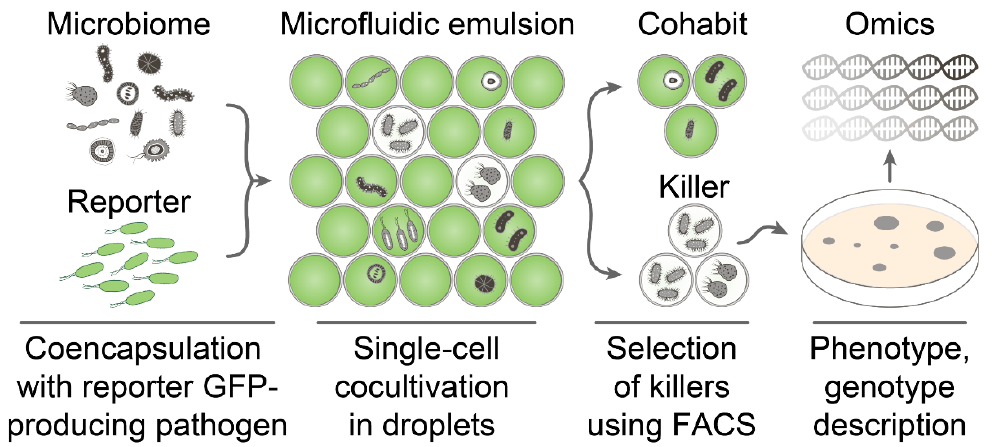
Figure 1. The general pipeline of ultrahigh-throughput screening of antimicrobial activity. The bacterial community is encapsulated with reporter GFP-producing pathogen in biocompatible droplets of microfluidic double water-in-oil-in-water emulsion. Cocultivation of bacterial community with reporter bacteria in droplets results in two distinct populations containing bacterial cohabits and killers. The latter is selected by a low level of GFP fluorescence by FACS. The selected droplets are plated on agar to regenerate culturable killers analyzed by activity-guided metabolomics and genomics. Detailed phenotype and genotype description enable identifying antibiotics and their biosynthetic gene clusters.